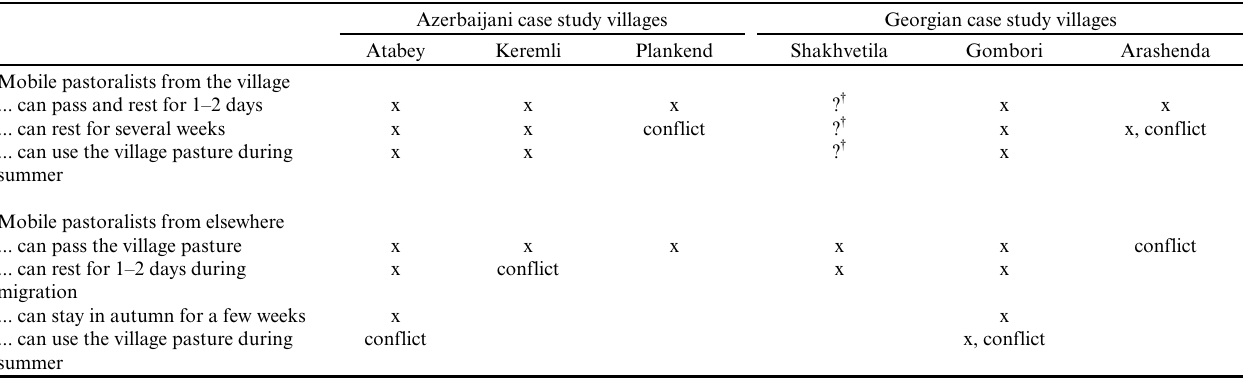
Table 6 . Rules for access and temporary use for mobile pastoralists in the case study villages.